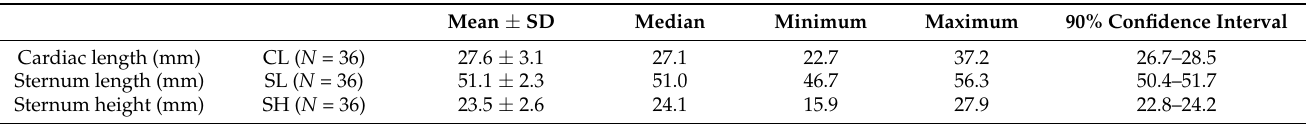
Table 2. Measurements from the LL radiographic projection. The mean value with standard deviation, minimum, maximum, and confidence intervals of the variables are